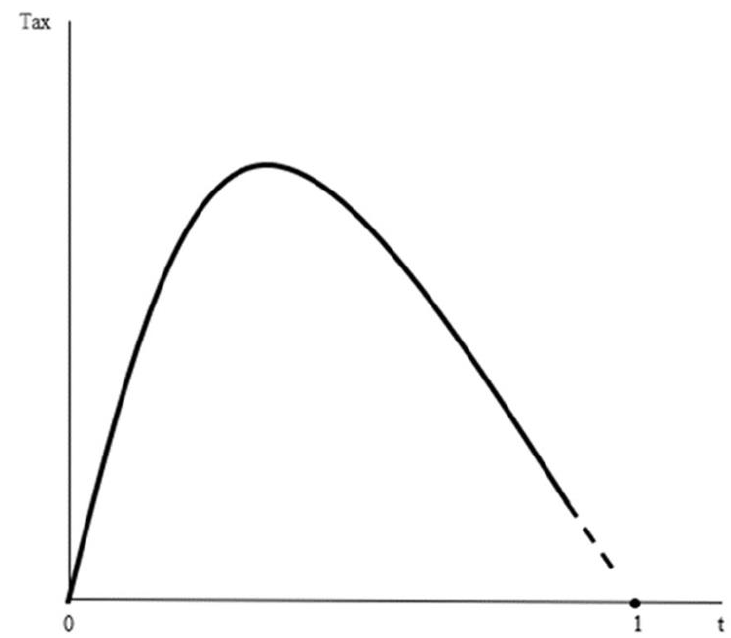
Figure 3. The single-peaked Laffer curve.